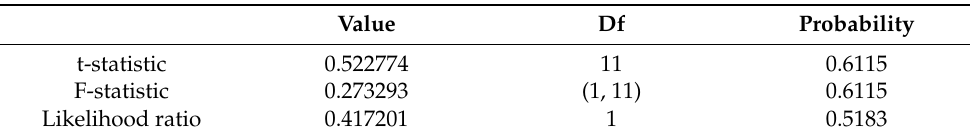
Table 2. Ramsey RESET Test. Specification: LOG_TMC LOG_FGB LOG_TRB LOG_BND LOG_INF C. Omitted Variables: Squares of fitted values.